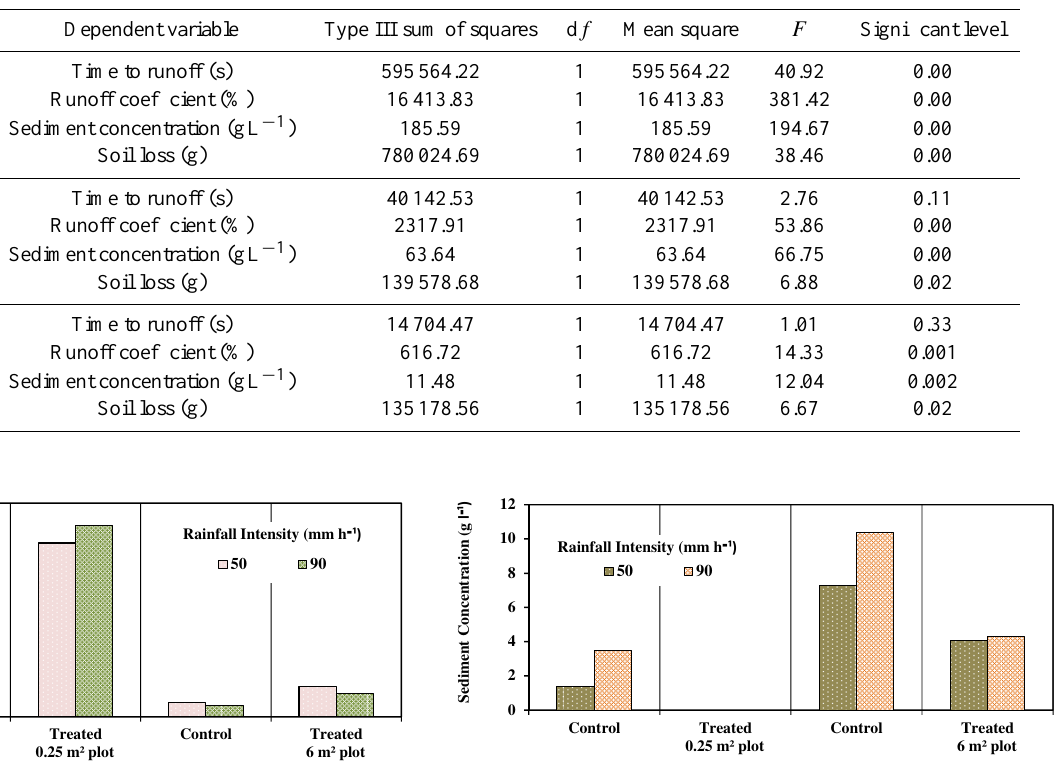
Figure 2. Average time to runoff for the two study scales and the two rainfall intensities.